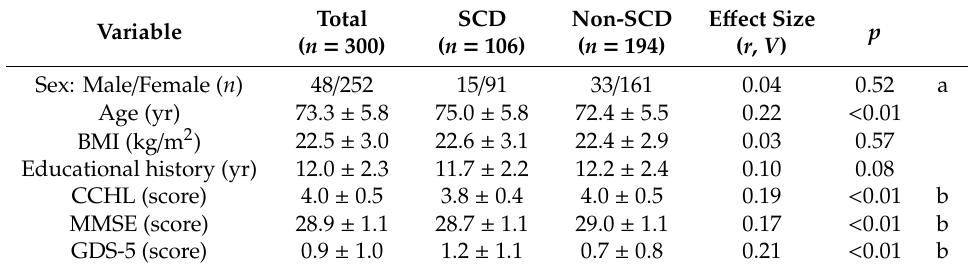
Table 2. Comparison of the fundamental information and measurements between the SCD and non-SCD